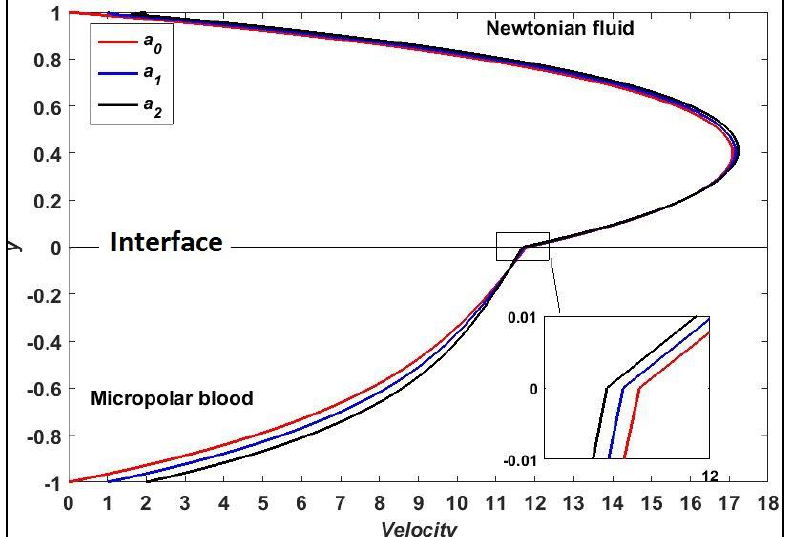
Figure 5. Velocity profile with the fuzzy boundary.